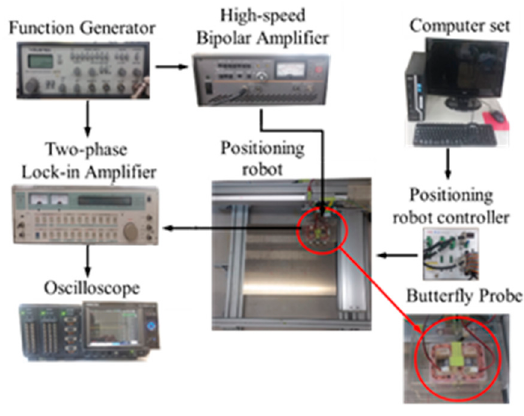
Figure 8. Experimental set-up. Table 3. Specifications of excitation and detection coils.